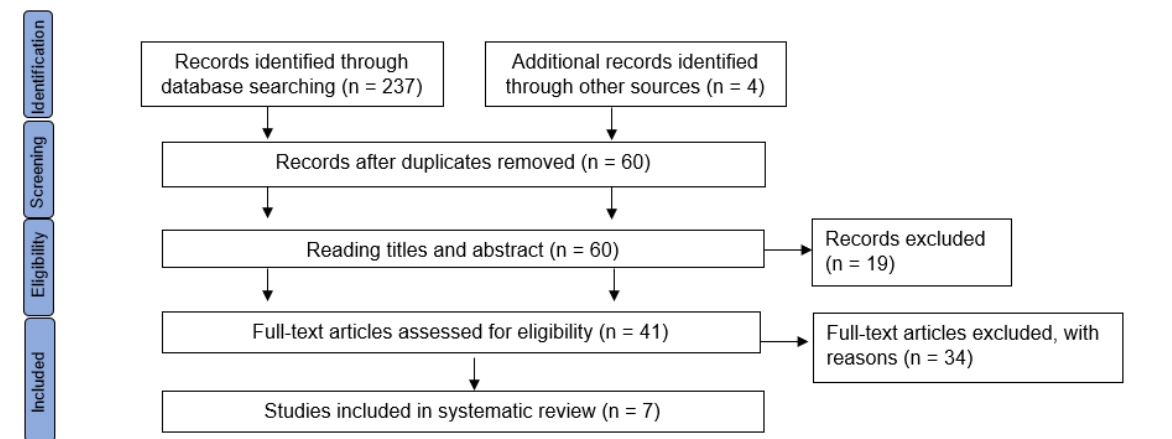
Figure 1. Article selection flowchart. Adapted from Preferred Reporting Items for Systematic Reviews and Meta-Analyses (PRISMA).